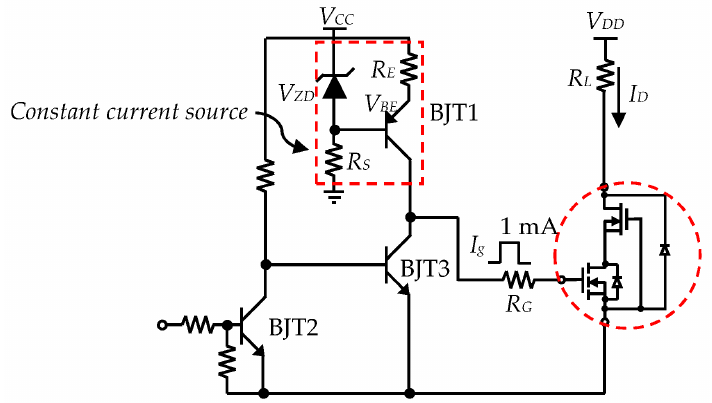
Figure 8. Test circuit for the gate charge measurements. Gate current I g was set to 1 mA by using the constant current source.